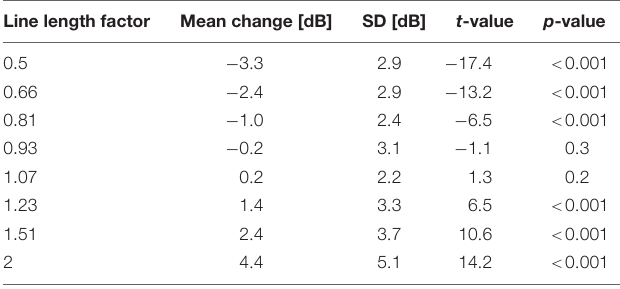
Means and standard deviations across subjects and stimuli, and one-sample t-tests comparing to zero change.